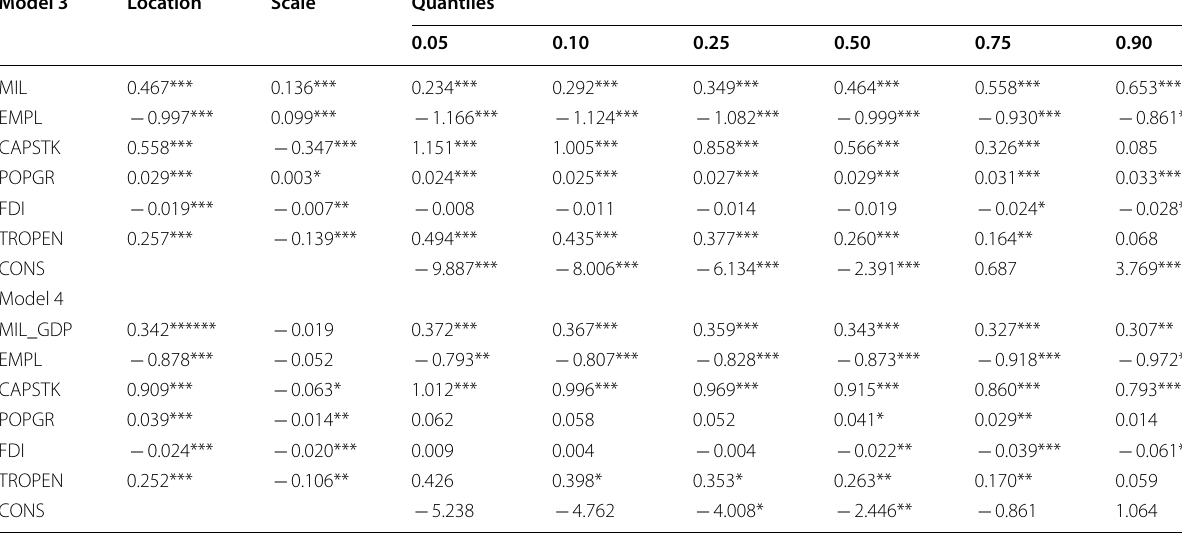
***, ** and * represent 1%, 5% and 10%, respectively. Note: RGDPPCP, MIL, MIL_GDP, EMPL, POPGR, CAPSTK, FDI, TROPEN and CONS denote real gross domestic product per capita (M’USD), military expenditure (M’USD), military burden, employment (M), population growth (%), capital stock at a constant price, 2017 (M’USD), foreign direct investment (%), trade openness (%) and constant,